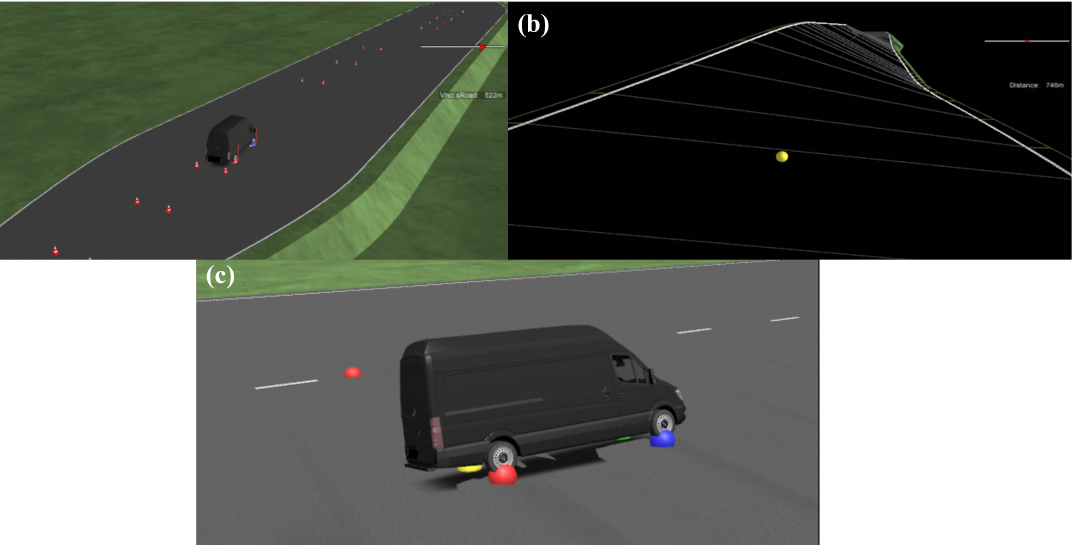
Figure 2. Driving scenarios created in IPG CarMaker ® for the LTR estimation: double lane change manoeuvre on a flat road ( a ) , straight manoeuvre on a banked road ( b ) and straight manoeuvre on an asymmetrical waves road ( c